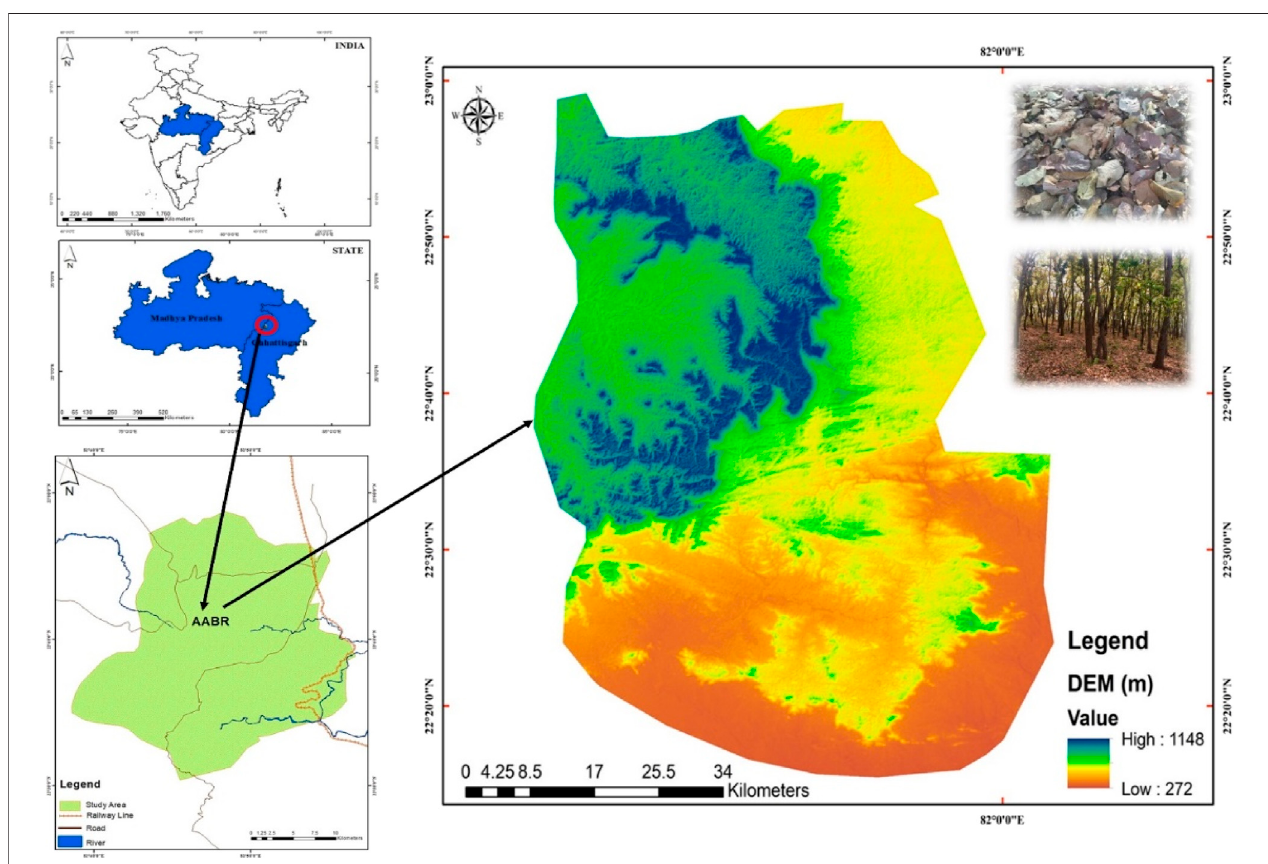
FIGURE 1 | Location Map (left side) and digital elevation model (DEM) (right side) of the study area.